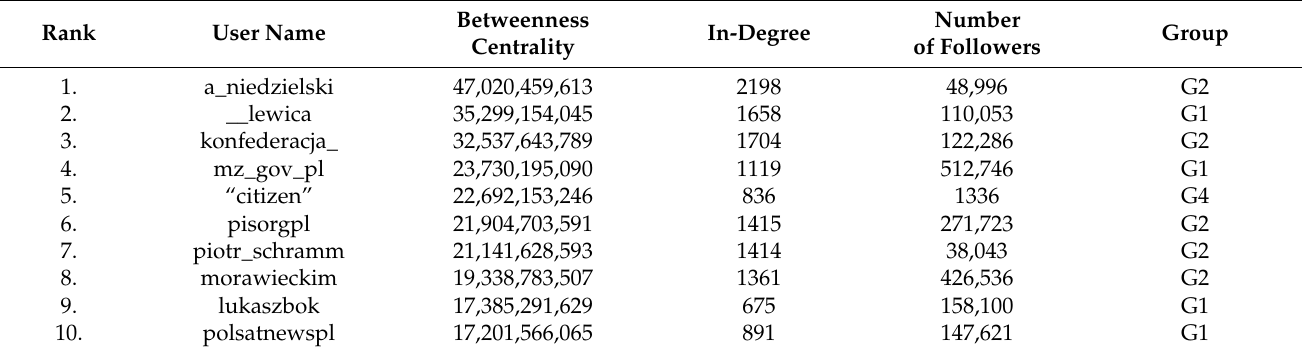
Table 4. Top 10 users ranked by betweenness